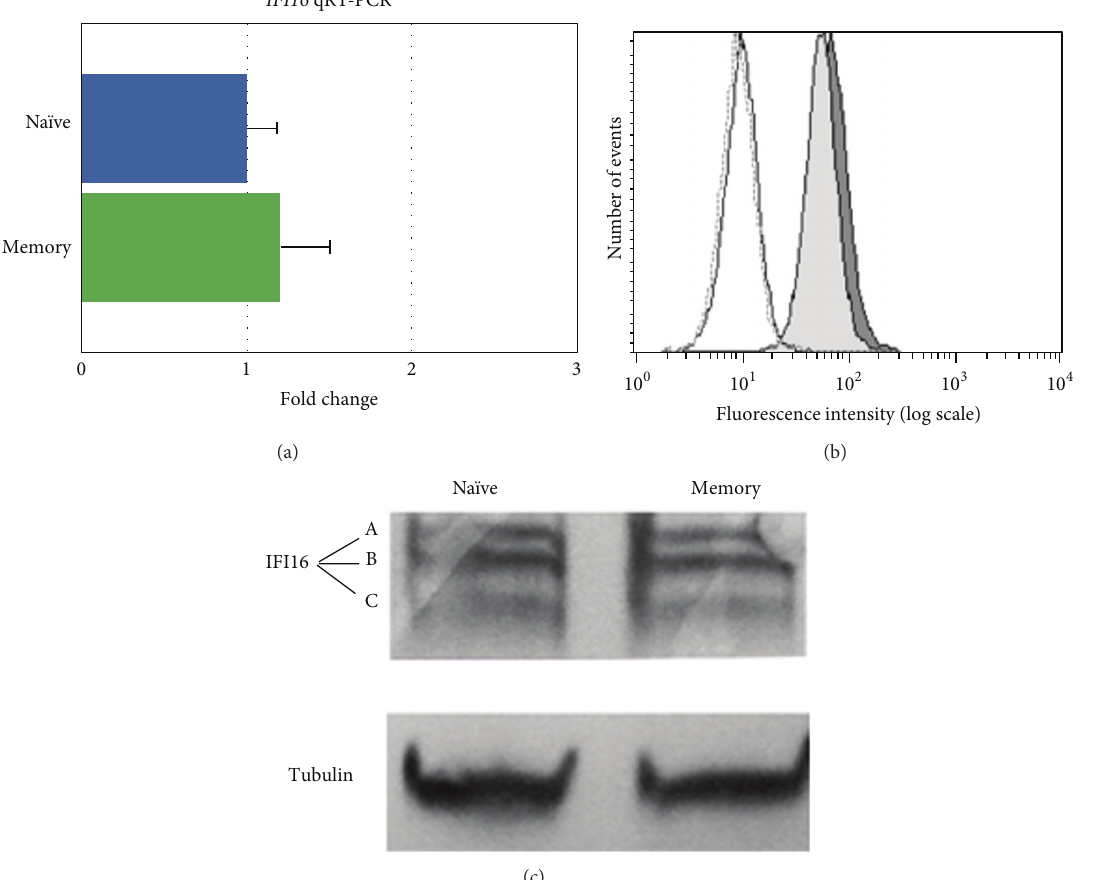
Figure 3: IFI16 protein and mRNA expression analysis in na¨ıve and memory B-cells purified from peripheral blood. In (a), IFI16 mRNA levels were determined using qRT-PCR. The IFI16 mRNA expression relative quantification was calculated with the ΔΔ C t method [34, 35]. The results are shown for the na¨ıve B-cell subset relative to the memory B subset. The data represent the mean ( ± SD) of three independent experiments performed in duplicate. In (b), flow cytometry analysis of intracellular IFI16 protein was performed in na¨ıve and memory B- cell subsets purified from peripheral blood. Na¨ıve (light grey histogram) and memory (grey histogram) B-cells were stained by indirect immunofluorescence with a rabbit anti-IFI16 antibody (1:40 in 0.2% saponin/PBS) and, subsequently, with a FITC-conjugated sheep anti- rabbit IgG (1: 100 in 0.2% saponin/PBS). The white histograms are the negative controls (dotted line, memory cells, solid line, and na¨ıve cells) represented by na¨ıve and memory B-cells stained with indirect immunofluorescence with a rabbit anti-HIV-1 p24 antibody (1: 40 in 0.2% saponin/PBS) and, subsequently, with a FITC-conjugated sheep anti-rabbit IgG (1: 100 in 0.2% saponin/PBS). A representative experiment is shown. In (c), western blot analysis of protein extract from peripheral blood memory and na ¨ ıve B-cell subsets ( 𝑛 = 3 ). Cell lysates were separated by gel electrophoresis and transferred to nitrocellulose membrane. The proteins were probed with rabbit anti-IFI16 polyclonal antibody and then incubated with an AP-conjugated anti-rabbit IgG and detected by colorimetric procedure. Tubulin protein was assayed as control. IFI16 A, B, and C isoform proteins were expressed similarly in memory and na¨ıve B-cell subsets. A representative experiment is